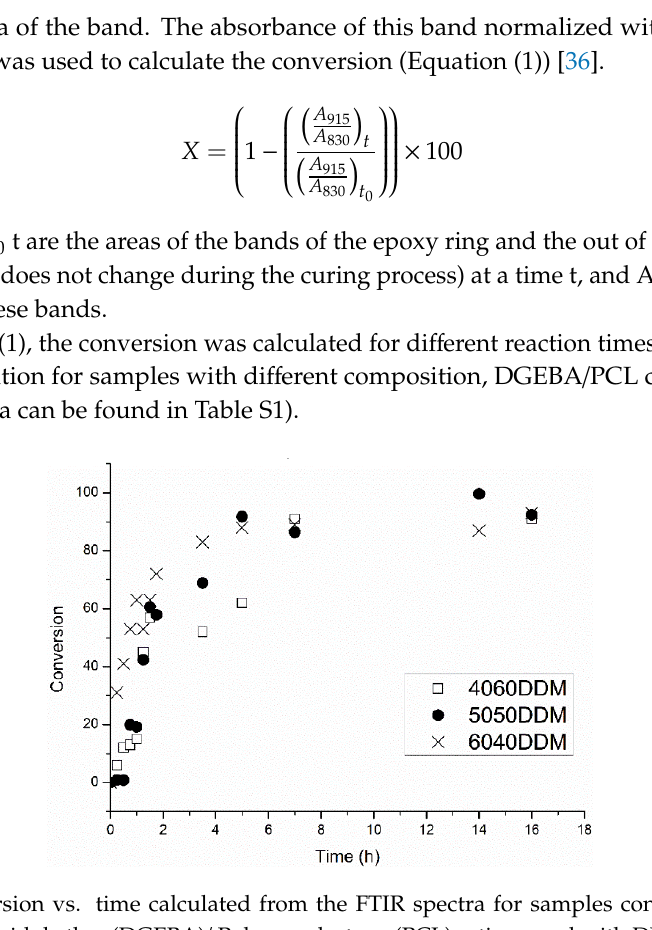
Figure 4. Differential scanning calorimetry (DSC) thermogram of sample 5050DDM, before and after 16 curing hours.